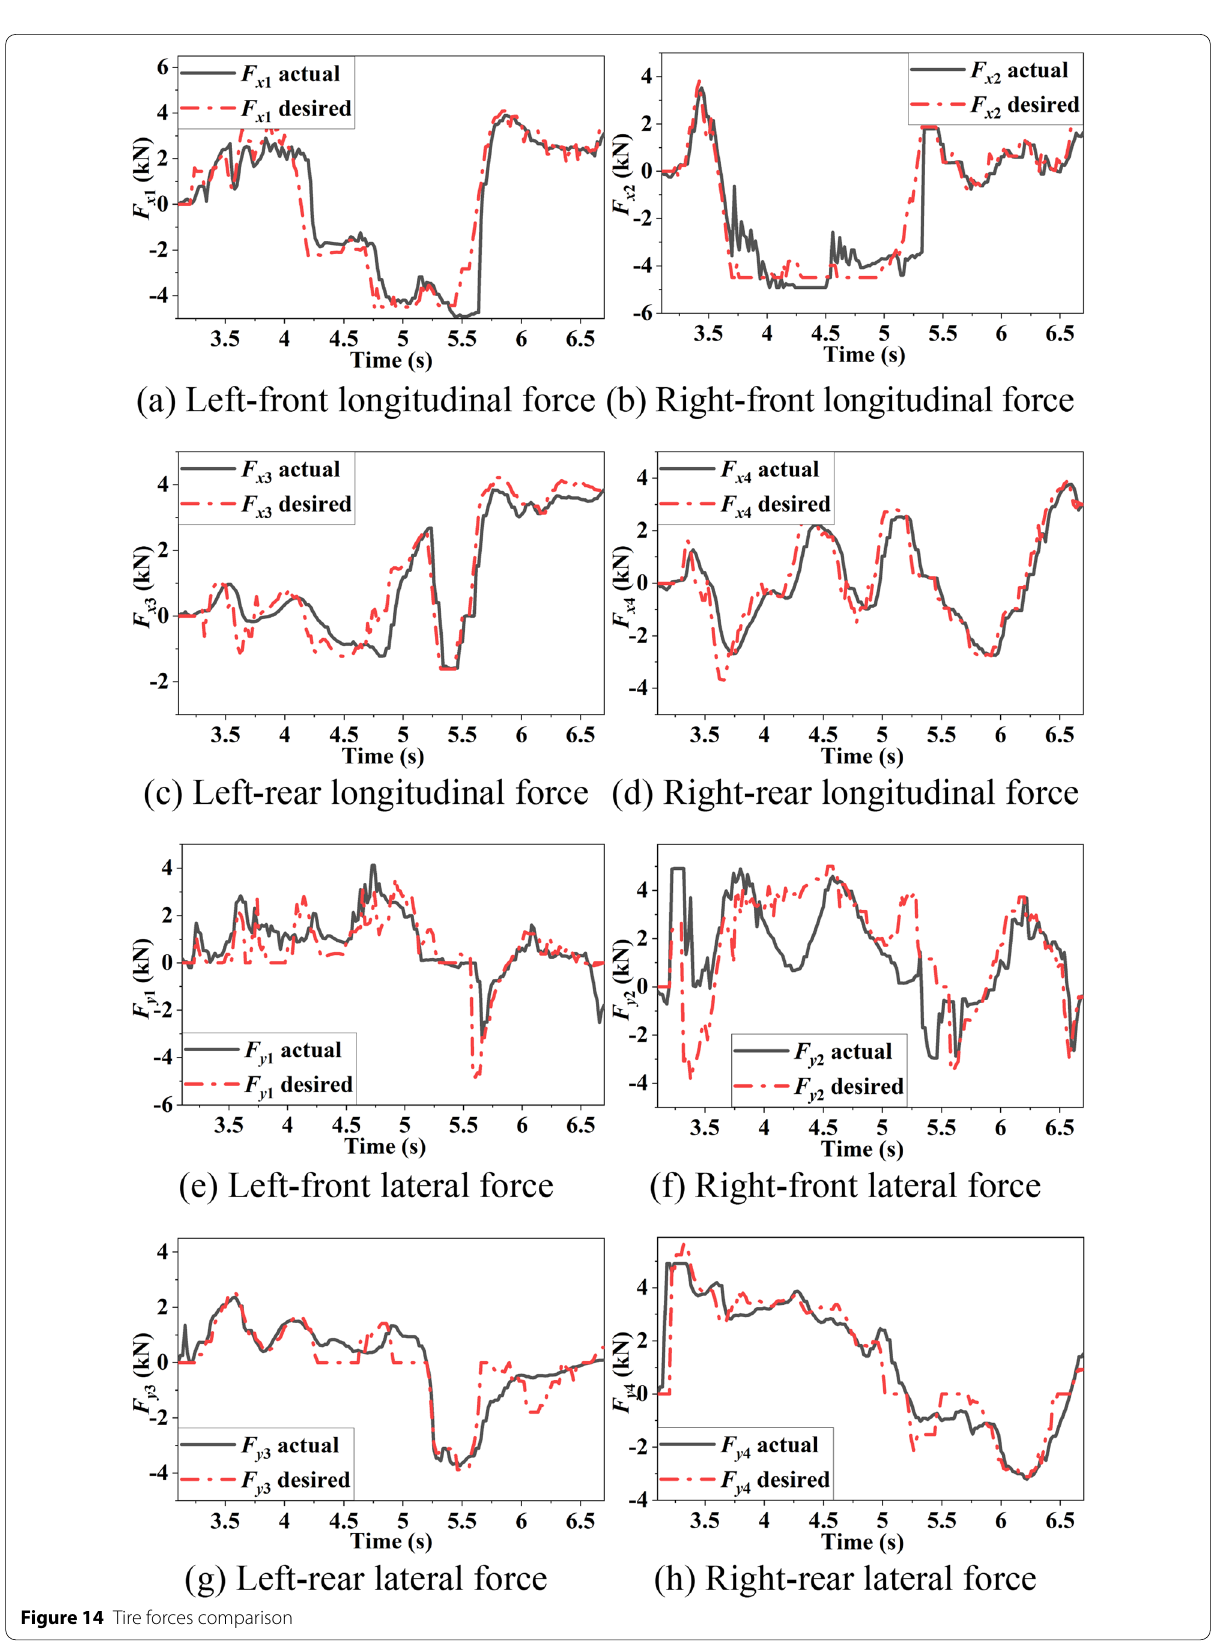
Figure 14 Tire forces